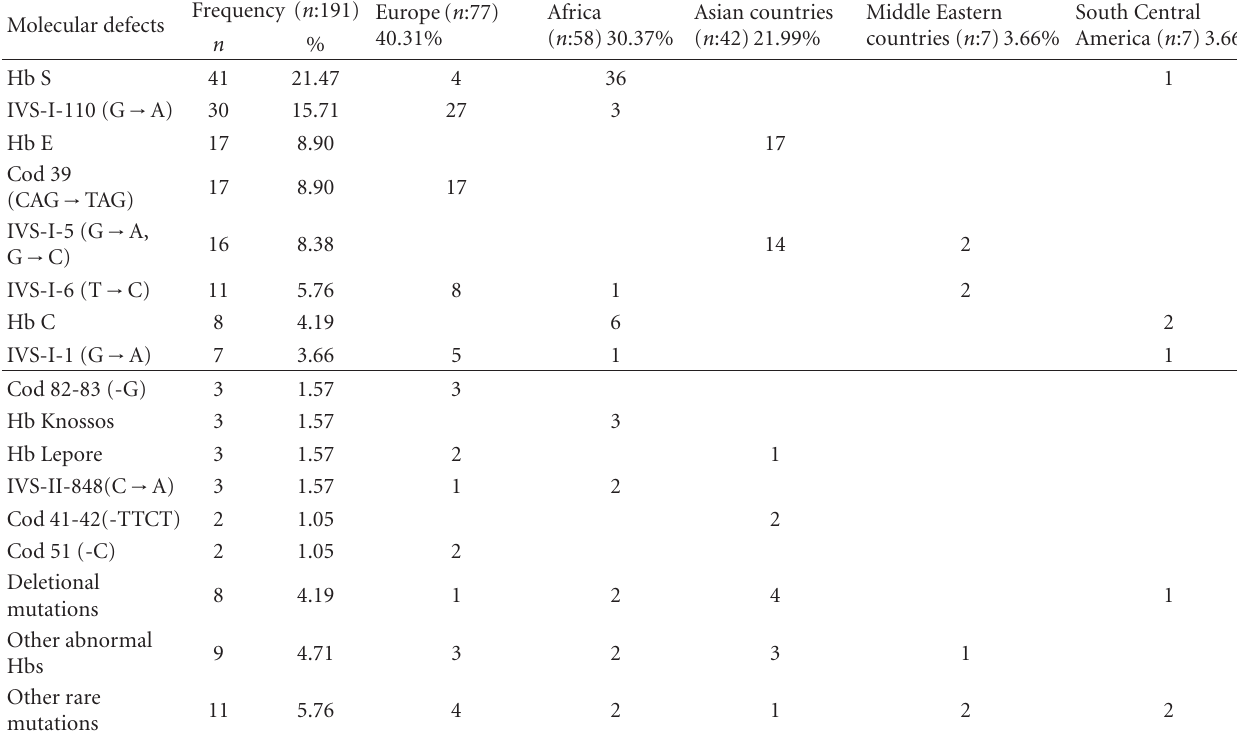
Table 1: Frequency distribution of β alleles ( β thal and Hb variants) in 191 heterozygous immigrants. Molecular